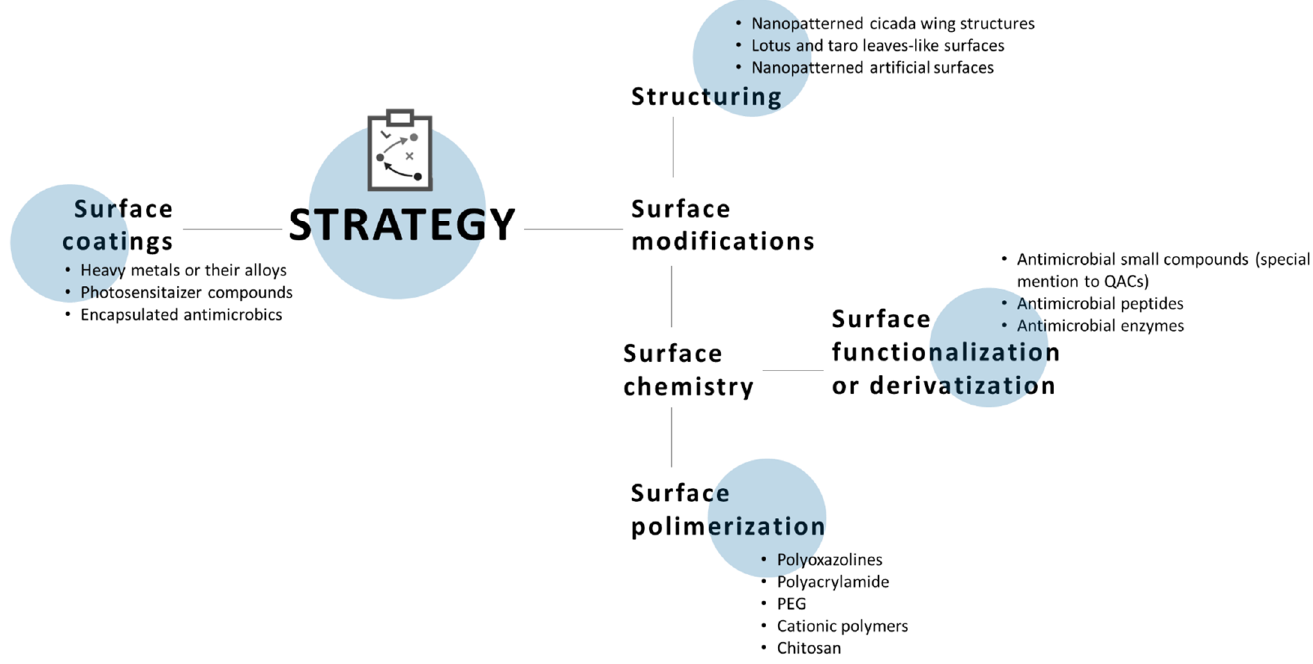
Figure 16. Different approaches in the design of antimicrobial surfaces.